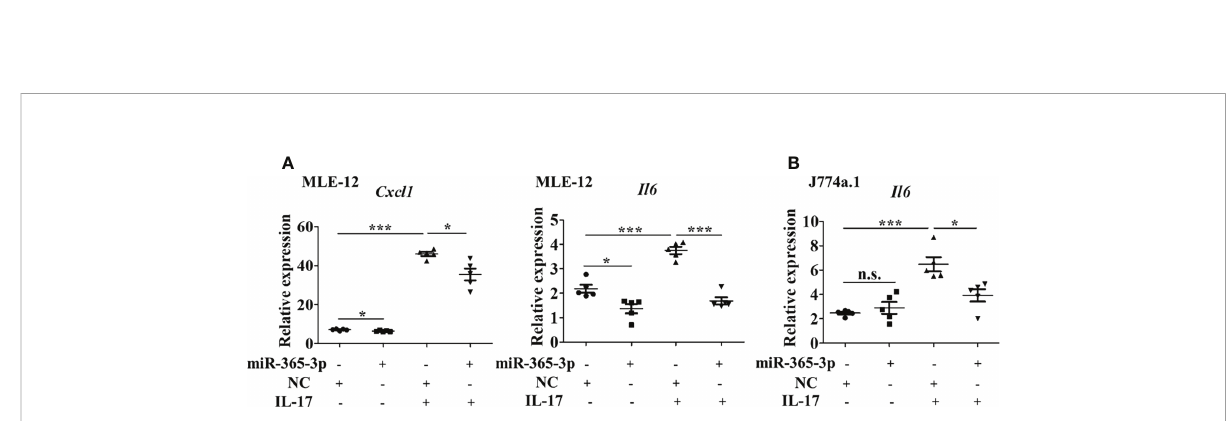
FIGURE 4 miR-365-3p negates IL-17-induced in fl ammatory cytokines expression in murine epithelial cells and macrophages. (A) Effect of miR-365-3p mimic on mRNA expression of KC and IL-6 in MLE-12 cells upon IL-17 treatment. N=5. (B) Effect of miR-365-3p mimic on mRNA expression of IL-6 in J774a.1 cells upon IL-17 treatment. N=3. *, P<0.05, ***, P<0.001. n.s., not statistically signi fi